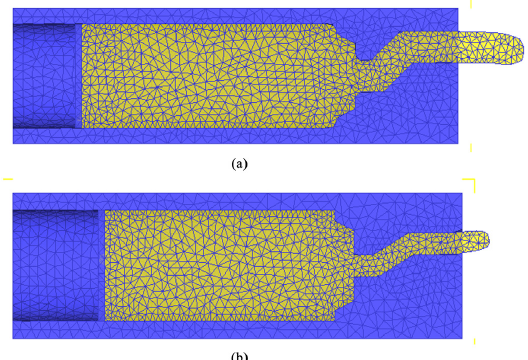
Figure 2. 3D FE model of dies and billet.